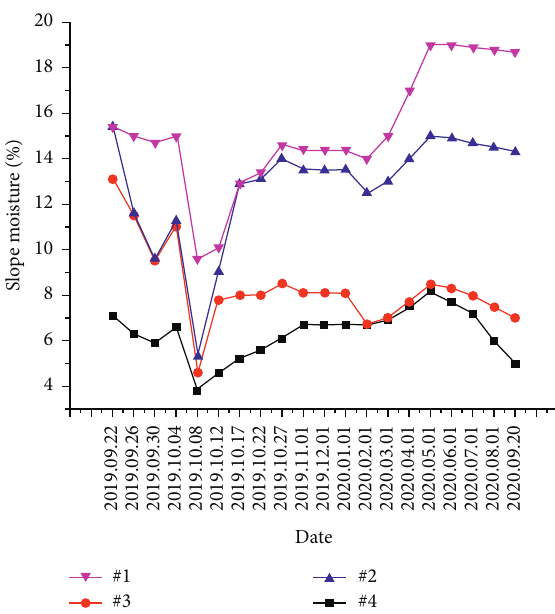
Figure 8: The slope moisture at different depths.